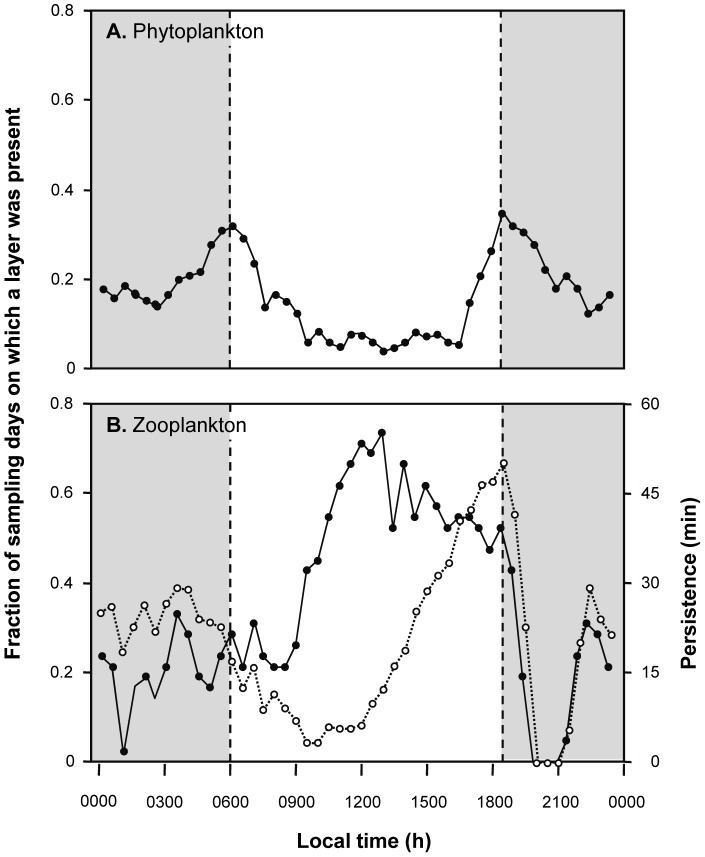
The frequency of occurrence of layers of phytoplankton (A) and zooplankton (B) as a function of local time detected using moored instruments across the two, 3-week studies is shown in the black symbols and solid lines.The y-axis shows the fraction of the 42 sampling days on which layers were detected in each time interval. Dusk and dawn are indicated by dashed lines separating the gray (night) from white (day) regions. Open circles and dashed lines in B indicate the average persistence, the total time a zooplankton layer was identified with no gaps in detection greater than 10 seconds, of zooplankton layers.